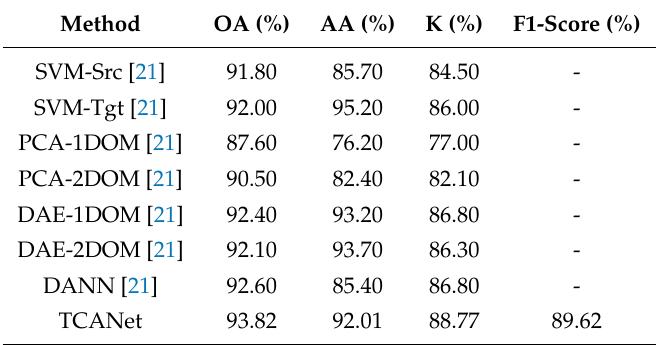
Table 6. Results for the Pavia City